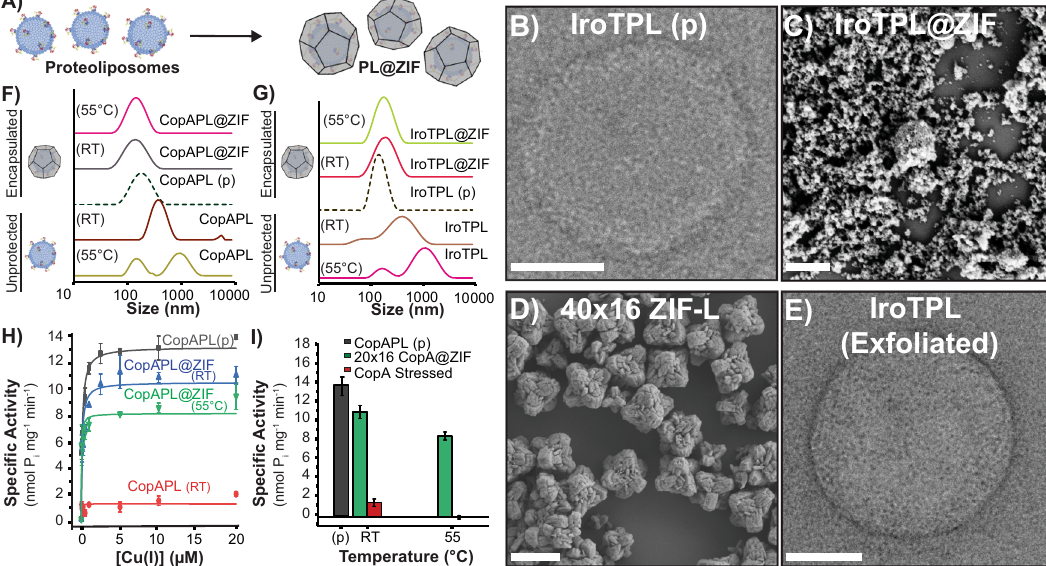
Fig. 5 Characterization of proteoliposome@ZIF bio-composites. A Biomolecular nucleation of CopA-PL and IroTPL in ZIF-L. B TEM micrograph of pristine IroT containing proteoliposomes. (Scale bar = 50 nm) C SEM micrograph of IroT-PL@ZIF bio-composites.(Scale bar = 1 μ m). D SEM micrograph of ZIF-L control. (Scale bar = 1 μ m). E TEM micrograph of a recovered fully functional IroT containing proteoliposome upon complete exfoliation. (Scale bar = 100 nm). DLS of ( F ) 20 × 16 CopAPL@ZIF bio-composites after thermal stressing followed by exfoliation compared to controls. CopAPL@ZIF 55 °C